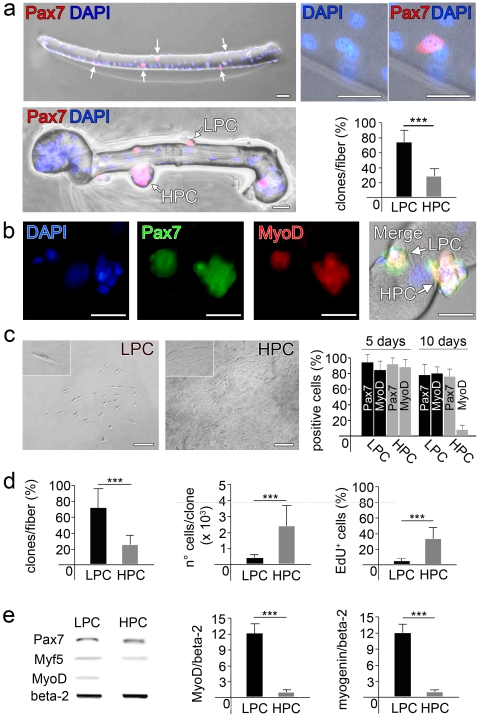
Identification and characterization of 2 subpopulations of SCs.(a) Evaluation of the average number of SCs per single fiber. Isolated FDB single fibers were immunostained with anti-Pax7 antibody and merged with DAPI immediately after isolation, in order to count the SCs (white arrows) per fiber (top panel left; high magnification on top panel right). Single fibers were also cultured in suspension for 5 days and SCs were evaluated. LPC and HPC are distinguishable on the fiber (indicated with LPC and HPC). SCs were immunostained with anti-Pax7 antibody and merged with DAPI (bottom left, bar = 100 µm). In the diagram percentage of LPC and HPC per single fiber (n = 50) is reported (bottom right, mean±s.d., ***p<0.001). (b) Immunostaining for Pax7 and MyoD, merged with DAPI, was performed on both LPC and HPC on fiber, showing that SCs in both clones are positive for such markers after 5 days in suspension culture (bar = 100 µm). (c) Cloning of freshly isolated SCs through limiting dilutions in 96-well dishes. LPC and HPC are distinguishable after phase-contrast microscope analyses (left, bar = 100 µm, insets with higher magnification). In the diagram on the right the % of cells staining positive for Pax7 and MyoD, both in LPC and in HPC, after 5 and 10 days of culture respectively, is reported. (d) In the diagram on the left, percentage of LPC and HPC derived from cloning of freshly isolated SCs per single fiber, then diagrams showing that average number of cells (center) and percentage of EdU-positive cells in LPC and HPC (mean±s.d., ***p<0.001) (right). (e) Semiquantitative PCR analysis for myogenic markers Pax7, Myf5 and MyoD (house-keeping gene: beta-2-microglobulin) (left), and real-time PCR analysis for MyoD (center) and myogenin (right) (mean±s.d., ***p<0.001, normalized against housekeeping gene beta-2-microglobulin) on pools of LPC and HPC.